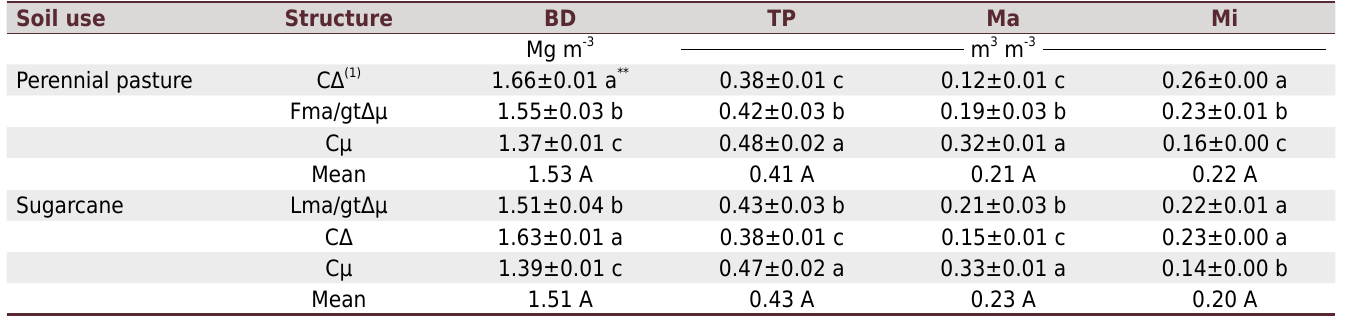
Table 2. Bulk density (BD), total porosity (TP), macro (Ma), and microporosity (Mi) of the structures described in the three soil profiles under perennial pasture and sugarcane in an Oxisol Soil use